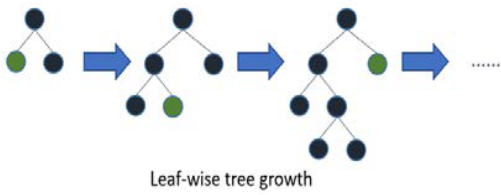
Figure 3. Schematic diagram of leaf-wise strategy growth tree .